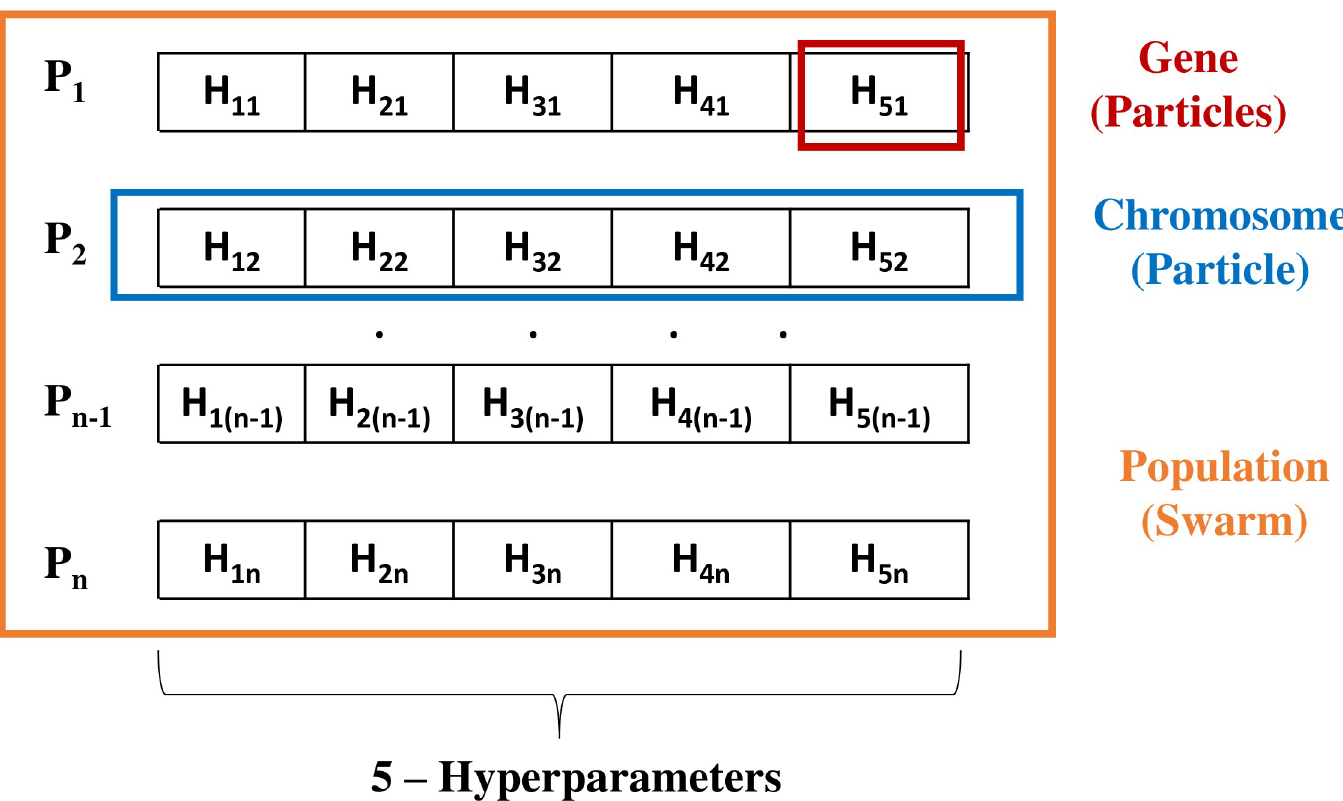
Fig 6. The architecture of the population (the